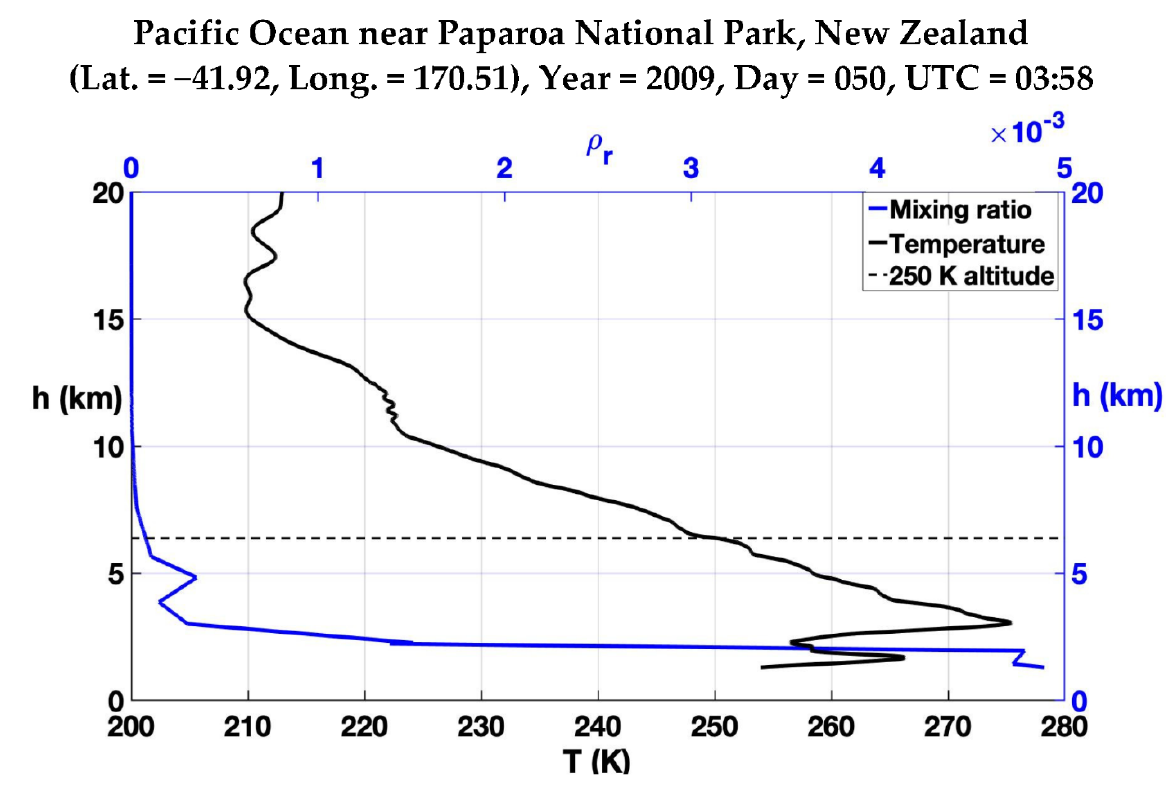
Figure 6. Mixing ratio profile (blue) and temperature profile (black) from an RO event colocated with a radiosonde excursion. The 250 K threshold altitude for air temperature is also plotted.